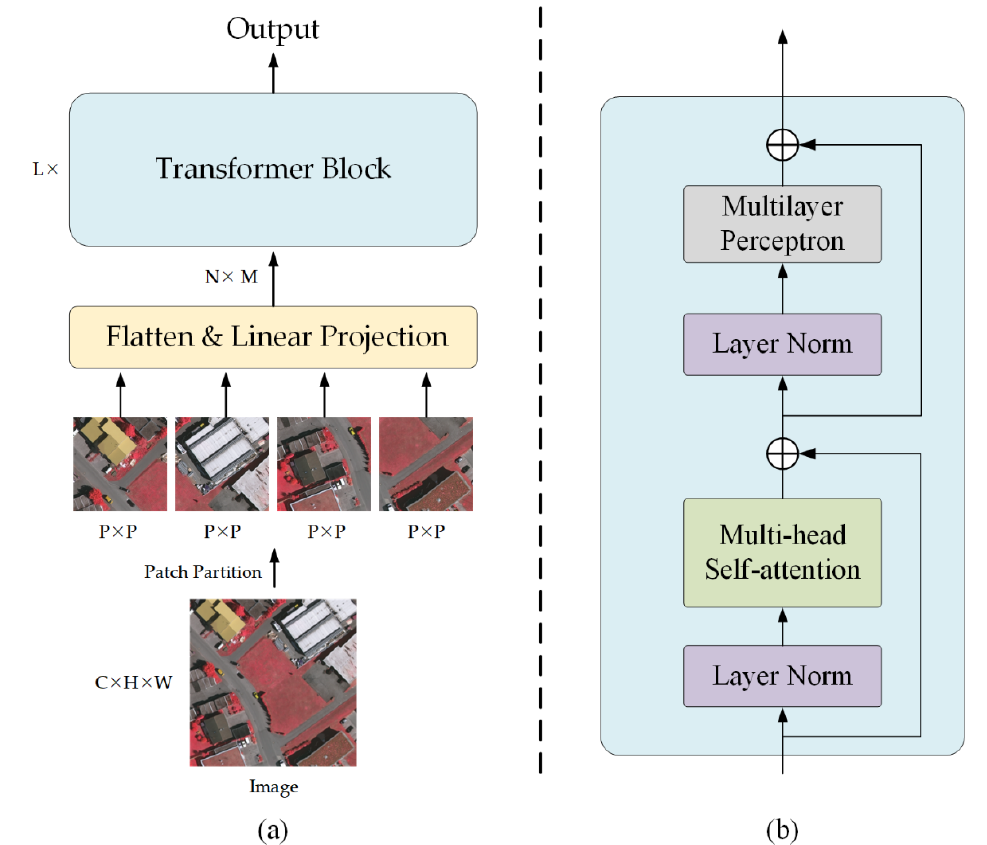
Figure 1. ( a ) Illustration of the schematic flowchart of the Transformer. ( b ) Illustration of a standard transformer block.